Question: Briefly state, in one sentence, what is plotted here.
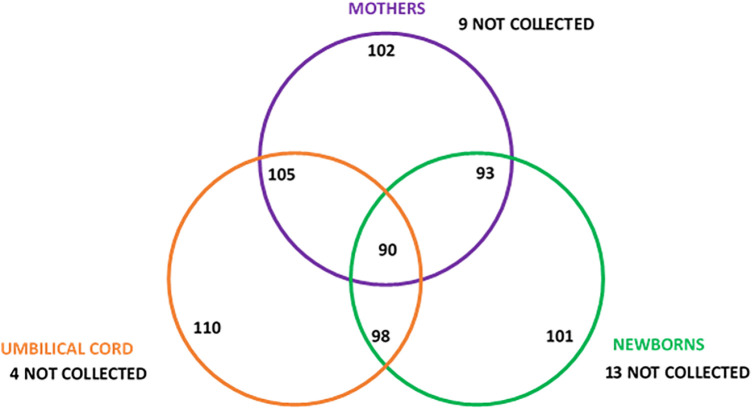
Answer: Venn diagram showing the total number of samples collected in each group. From the center outward, the 90 dyads with a complete sampling schedule (mother, child, and newborn) and the number of uncollected samples for each group are indicated.